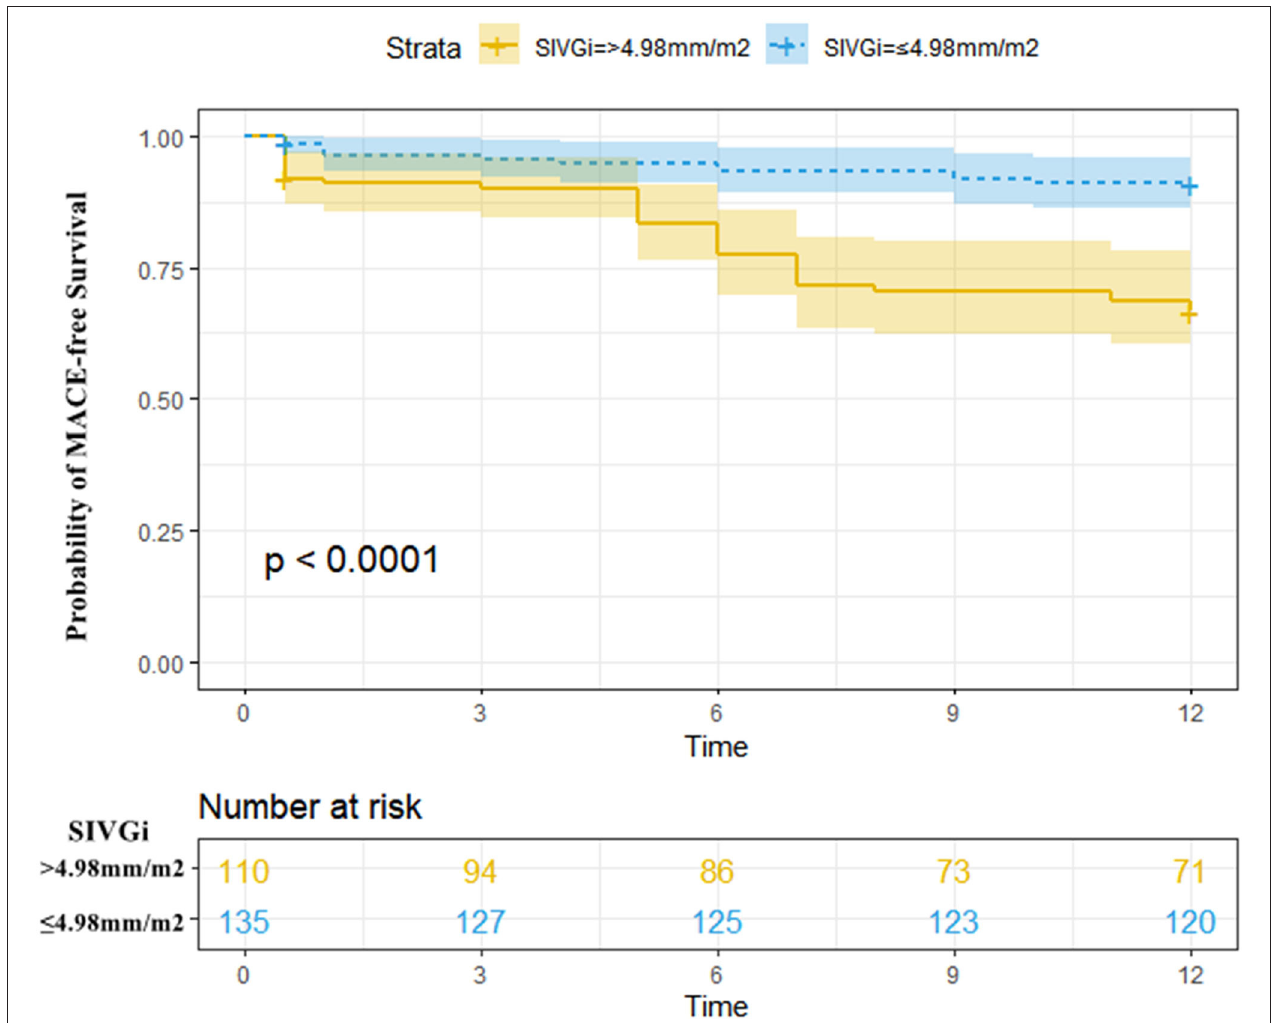
FIGURE 2 | Kaplan–Meier MACE-free survival estimated stratified by SIVGi in all patients with STEMI. Patients with higher SIVGi displayed a significantly higher risk of a first MACE. Central line represented the survival curves and the upper and lower lines of the colored areas correspond to the 95% CI. MACE, Major adverse cardiac events; SIVGi, Superior interventricular groove PCAT thickness